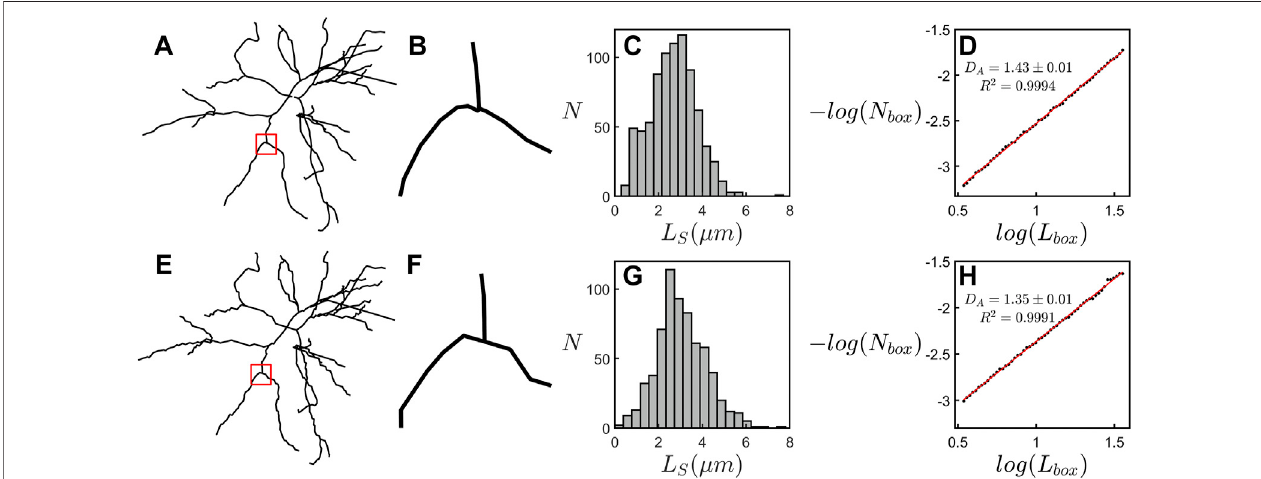
FIGURE 6 |(A – D) examinethe scaling behavior ofan example neuron from ATN-ENR-PS group. (A) The example neuron ’ s basal arbor. (B) A magni fi cation of the regionspeci fi edbytheredsquarein (A) . (C) Ahistogramshowingthenumberofdendriticsegments, N S ,acrosstherangeofdendriticsegmentlengths, L S ,forthearbor in (A) . (D) A scaling plot showing the results of the box-counting fractal analysis of the arbor in (A) . (E – H) Equivalent panels to (A – D) for the arbor after uploading to NeuroMorpho.Org.